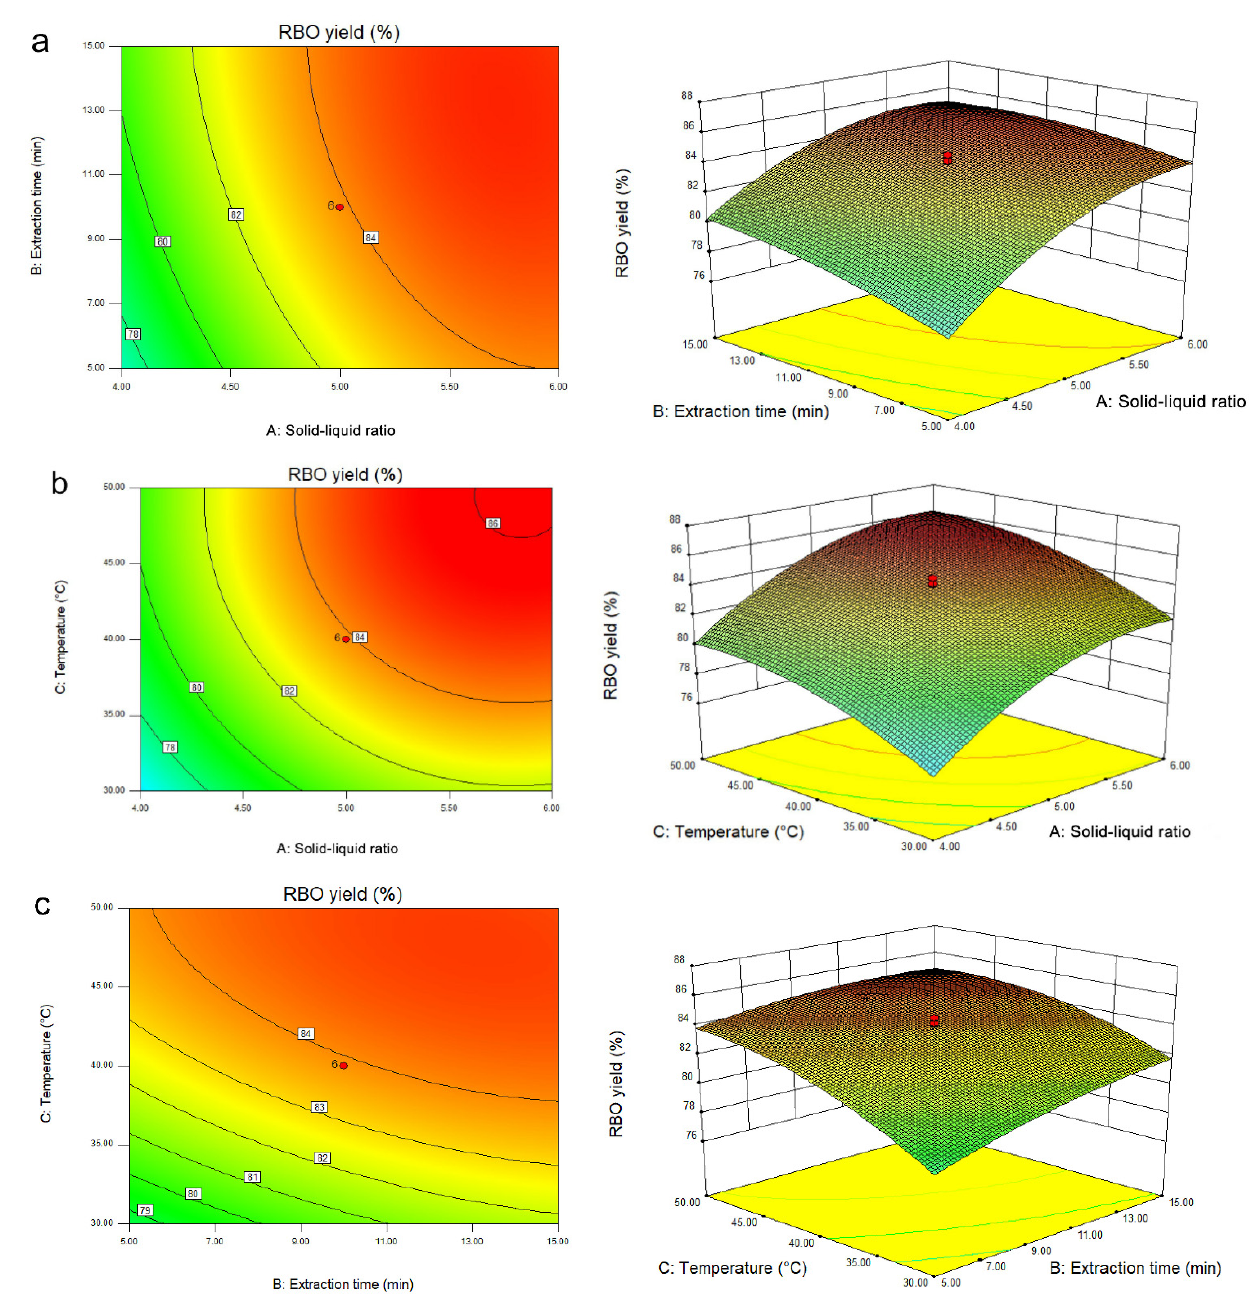
Figure 4. Contour plots and response surface plots of the interactive effects of different factors on RBO yield: ( a ) extraction time and solid–liquid ratio; ( b ) temperature and solid–liquid ratio; ( c ) temperature and time; (A) solid–liquid ratio; (B) extraction time; (C) temperature.